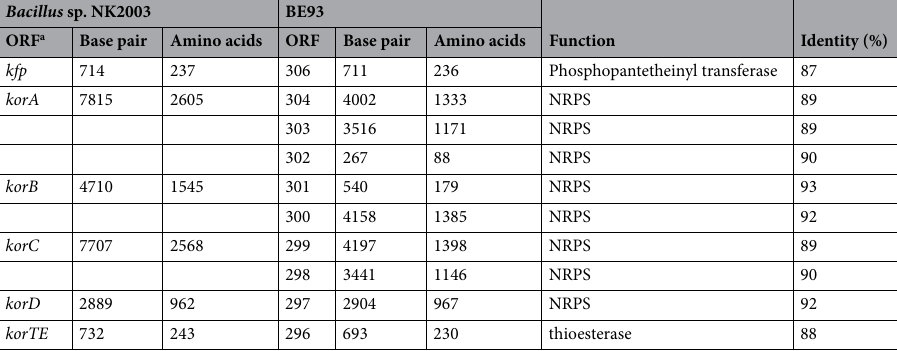
Table 1. Open reading frames (ORFs) representing the koranimine biosynthetic gene clusters (BGCs) in Peribacillus frigoritolerans BE93. a Genes encoding phosphopantetheinyl transferase ( kfp ), koranimine ( korA , korB , korC , korD ), type II thioesterase ( korTE ), non-ribosomal peptide synthase